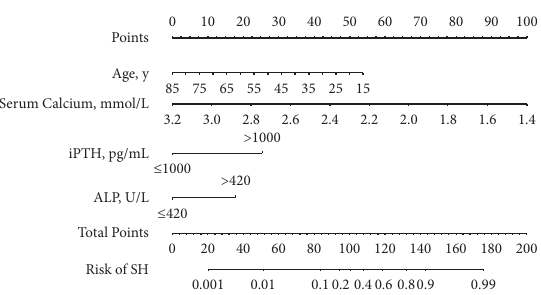
Figure 1: Nomogram for preoperative prediction of server hy- pocalcemia (SH) following total parathyroidectomy (TPTX) without auto-transplantation in patients with secondary hyper- parathyroidism (SHPT). Points are signed for age, preoperative serum calcium level, preoperative serum iPTH level, and pre- operative serum ALP level. Te score for each value was assigned by drawing a line upward to the “points” line, and the sum of the four scores was plotted on the “total points” line (probability of